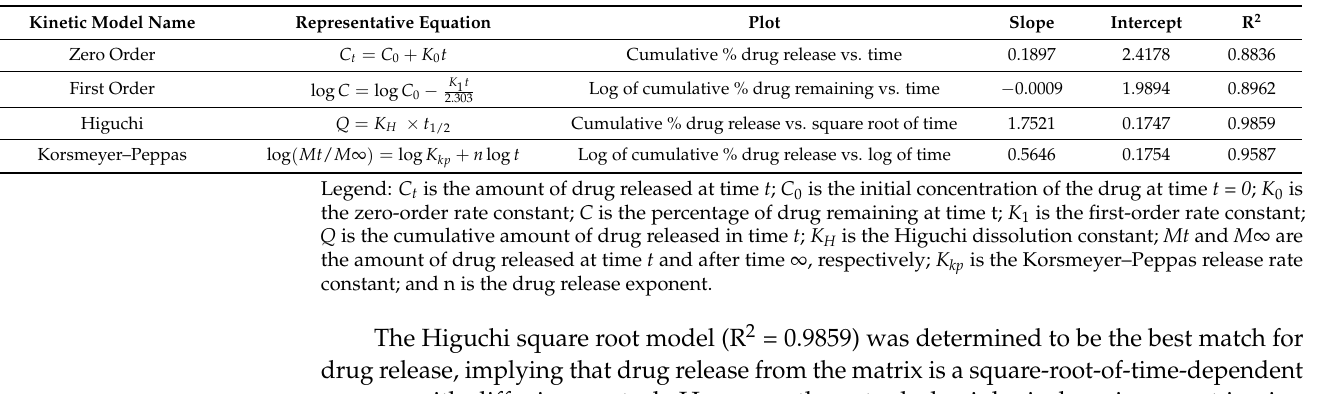
Table 2. Representative equations, plots, slopes, intercepts and correlation coefficient (R 2 ) values calculated from four kinetic